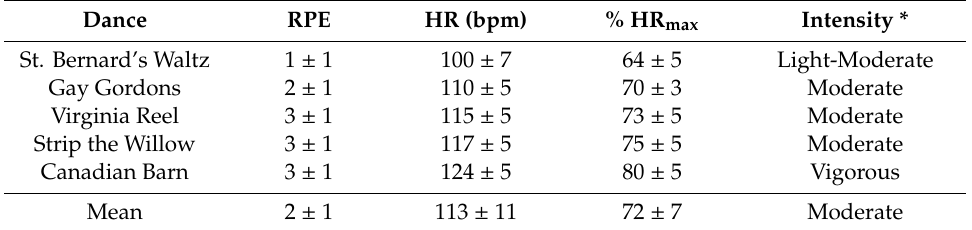
Table 2. Mean ratings of perceived exertion (RPE) and mean heart rate (HR) calculated from averaged individual RPE and HR values recorded during dances of the second and third set of weeks 3 and 4 and HR as percentage of predicted individual maximal heart rate (% HR max ). Values are Mean ± SD, n = 14. Dance RPE HR (bpm) % HR max Intensity * St. Bernard’s Waltz 1 ± 1 100 ± 7